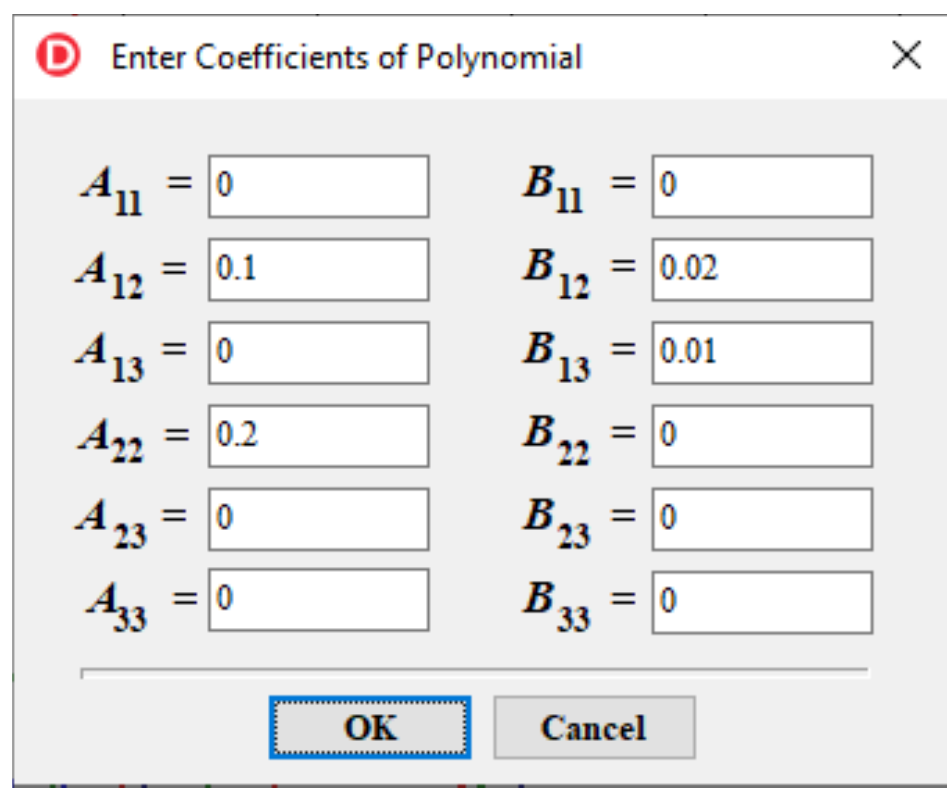
Set the poles parameters by using scroll bars—see the screenshot in Figure